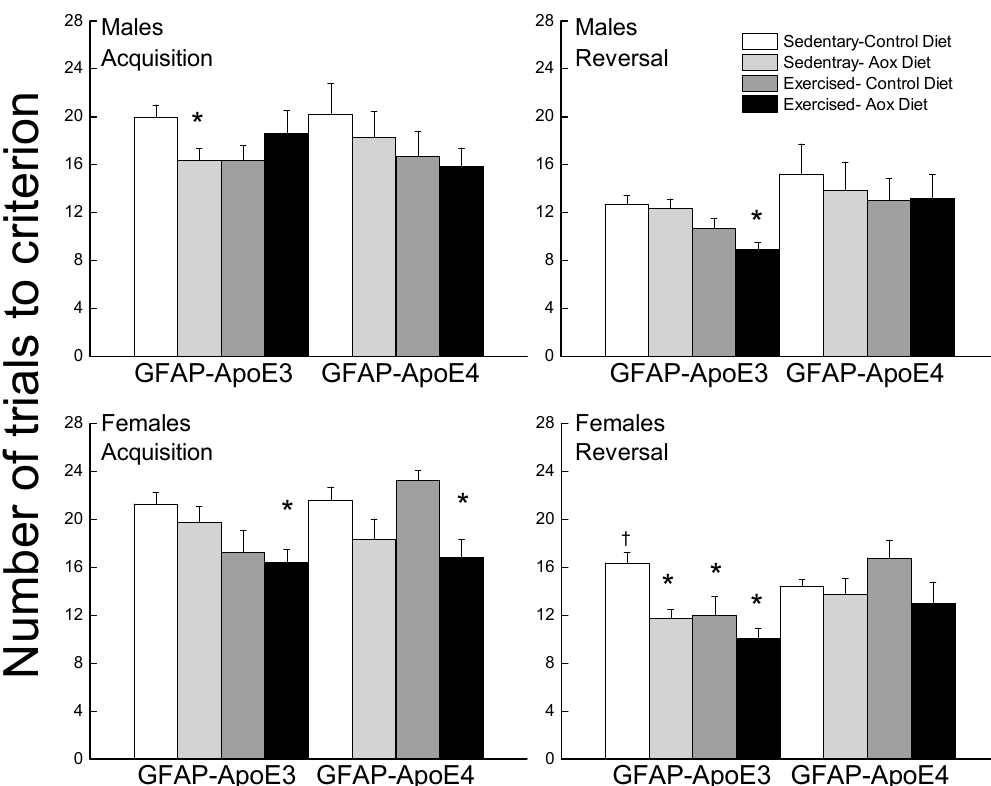
Figure 5. Exercise and antioxidants improved learning and cognitive flexibility in male and female GFAP-ApoE3 mice but not in GFAP-ApoE4 mice. Each value represents mean ± SEM, n = 8–16. * p < 0.05 vs. sex- and strain-matched Sed-Con groups; † p < 0.05 comparing strain-matched Sed-Con males and